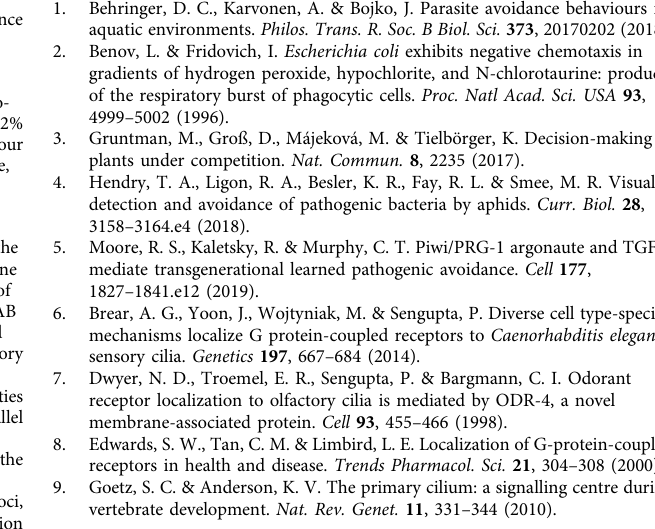
Fig. 5b, the homogeneous diffusion coef fi cient ( D ) in the PCMC is set to the D at x = 0 μ m shown in Fig. 4c. In case OCR-2 is linked to IFT, the probabilities for anterograde- and retrograde-directed transport are set at 1/3 and 2/3, respectively, in order to account for the difference in train frequencies in anterograde and retrograde directions 24 . The mode of transport (directed or diffusive) was ran- domly chosen on basis of the ratio extracted from the single-molecule analysis. The transport mode is kept constant over a time window of 15 time points (corre- sponding to 1.5 s), as used in the analysis of the experimental data. At t = 0s, 50 OCR-2 are positioned at each micrometer along the cilium, from 0 to 7 μ m. The number of steps in each trajectory is equal to 5000. The averaged intensity pro fi les are generated by calculating the density of molecules (histogram) over 3s identical to the intensity pro fi les generated from the experimental data. The pro fi les shown are taken from the simulations after a steady-state regime was